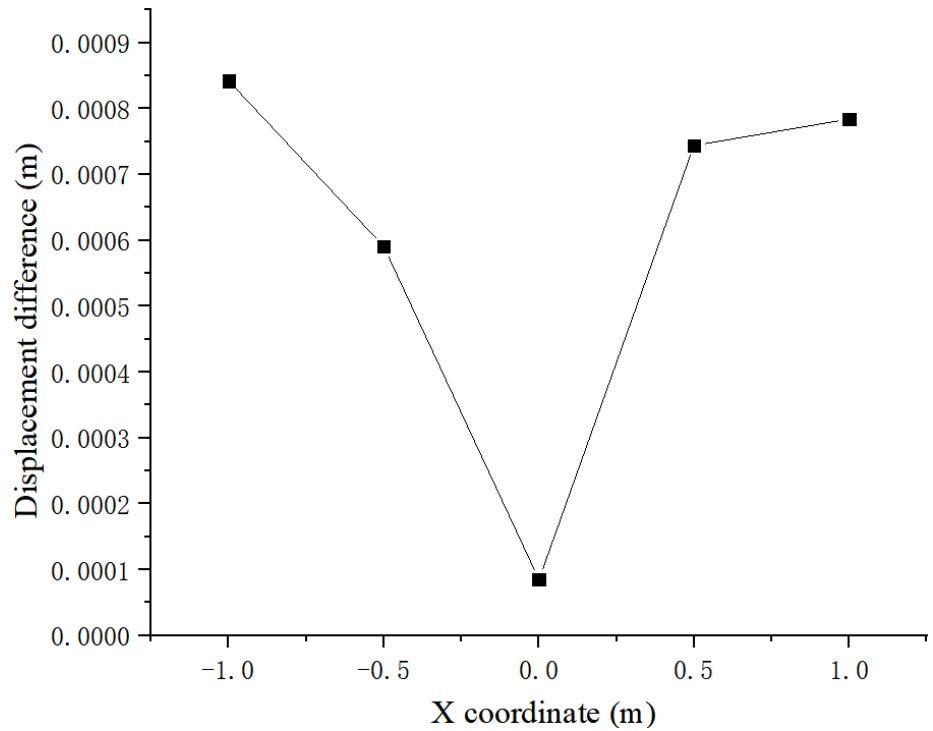
Figure 28. Variation of displacement difference at 14.625 m under different load positions.